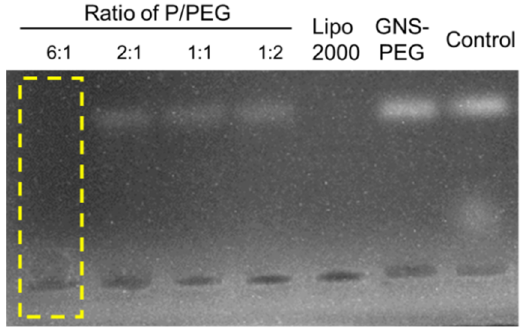
7 of 13 Figure 4. ( a ) TEM images of GNS; ( b ) TEM images of GNS-PEG; ( c ) SEM images of GNS. After obtaining stable and uniformly distributed GNS, we attempted to coat their surfaces with PEG to enhance their long circulation time in vivo, reduce possible toxic side effects and stabilize their surfaces to avoid aggregation of subsequent cationic pep-